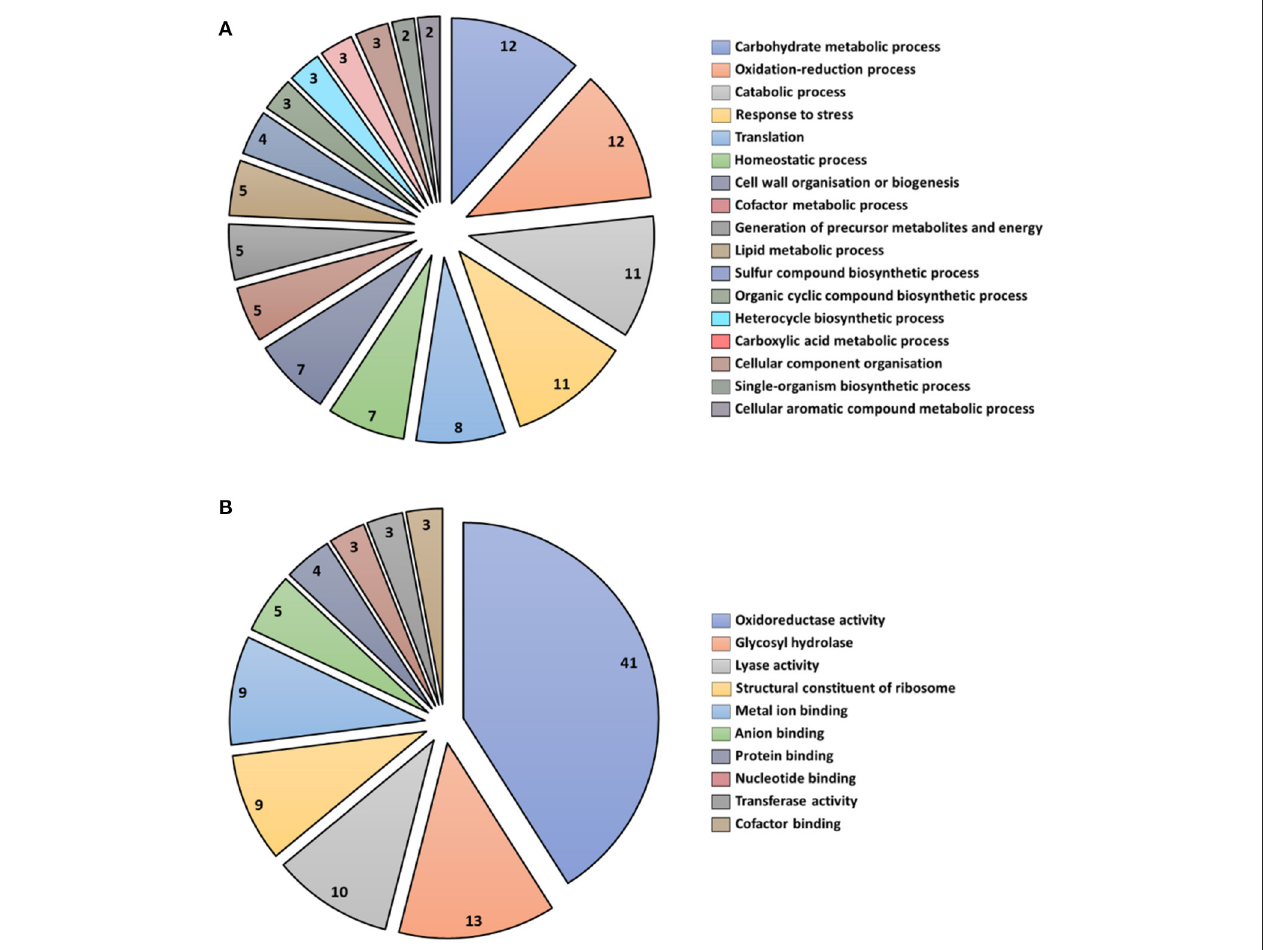
FIGURE 4 | Functional classification of all secreted proteins from T. virens at 5 days interaction. Blast2GO multilevel chart for (A) biological process and (B) molecular function. Score distribution represented as a percentage of each group is indicated inside the pie slices.